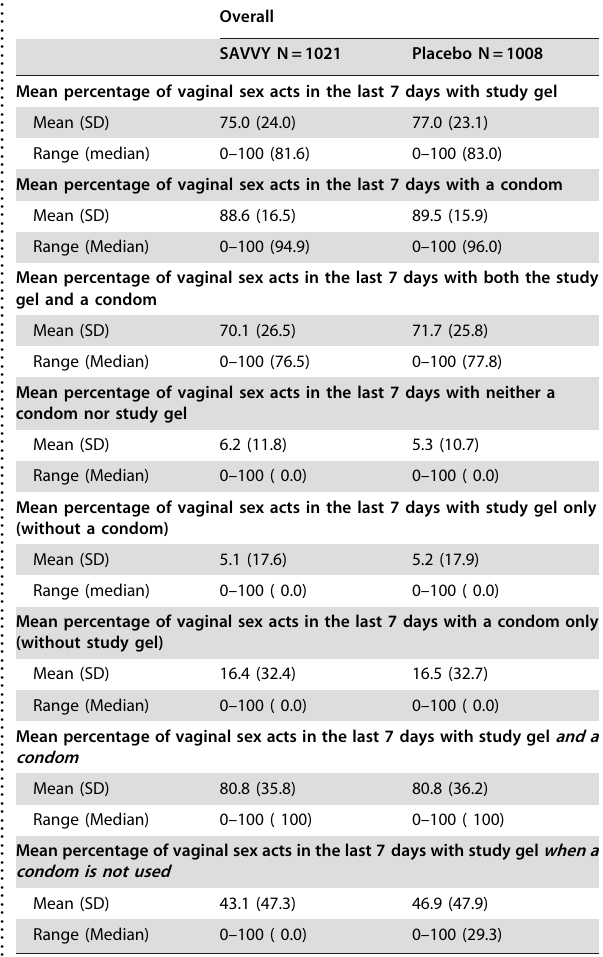
* For each participant and variable of interest (e.g., percentage of vaginal acts where study gel was used in the last 7 days prior to the follow-up visit), we first calculated the participant’s mean value of the variable of interest across all of their follow-up visits. (Follow-up visits where women reported 0 or a missing number of vaginal sex acts in the last 7 days are excluded from the calculation of a participant’s mean value.) The mean, SD, range, and median values of the distributions of these mean values were then obtained for each treatment